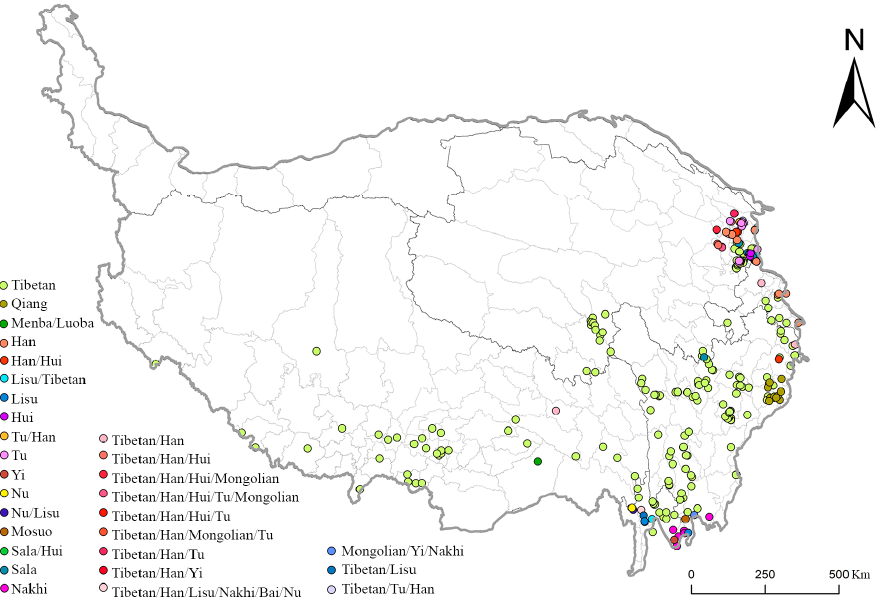
Figure 7. Distribution of traditional villages with different ethnic make-ups on the Tibetan Plateau. Table 5. Ethnic make-up of traditional villages on the Tibetan Plateau. Rank Ethnic Group Number of